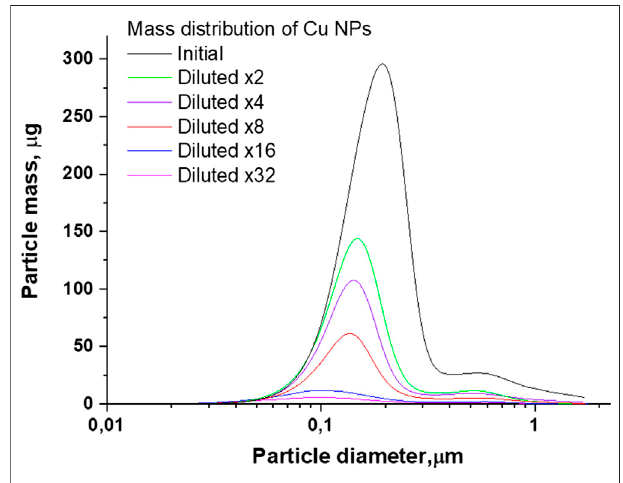
FIGURE 6 | The distribution of the mass of Cu nanoparticles by size depending on the amount of dilutions of the initial